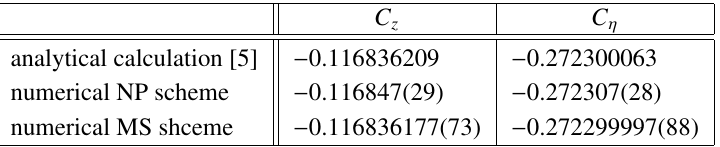
Table 1. The values of the second order contributions to dynamic critical